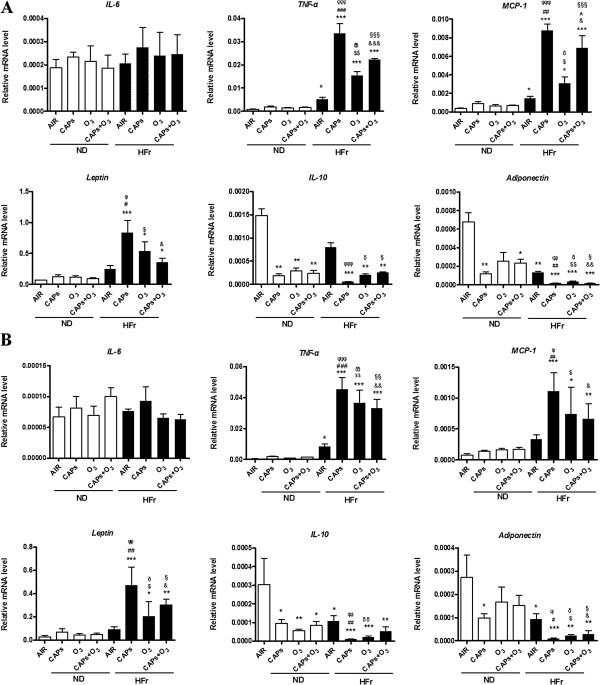
Alteration of the adipocytokine gene expression in EAT and PAT in response to CAPs and O3 exposures. EAT (A) and PAT (B) were from the rats fed a normal diet (ND) or high-fructose diet (HFr). *p < 0.05, **p < 0.01,***p < 0.001vs. ND-AIR; #p < 0.05,##p < 0.01,###p < 0.001 vs. ND-CAPs; $p < 0.05, $$p < 0.01 vs. ND-O3; &p < 0.05, &&p < 0.01, &&&p < 0.001 vs. ND-CAPs + O3; ^p < 0.05 vs. HFr -O3; φp < 0.05,φφp < 0.001,φφφp < 0.001 vs. HFr-AIR; δp < 0.05, δδp < 0.01, δδδp < 0.001 vs. HFr- AIR; §p < 0.05,§§p < 0.01, §§§p < 0.001 vs. HFr-AIR. N = 7–8.